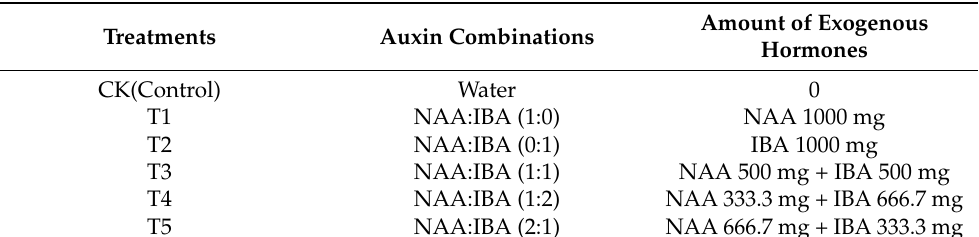
Table 1. Implementation methods of different auxin combinations.